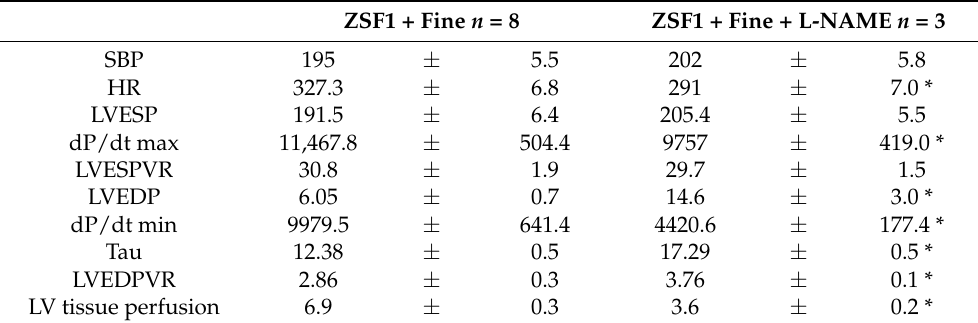
Table 1. L-NAME impact on cardiac function in ZSF-1 rats treated with